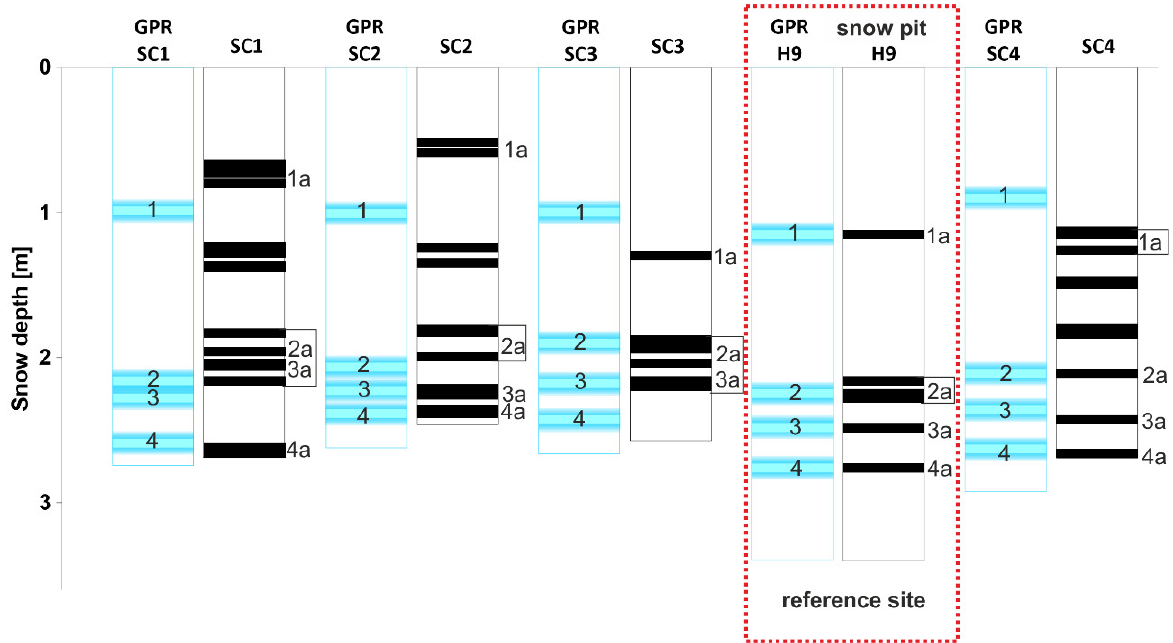
Figure 11. HLs recognized in snow cores, snow pit H9, and the nearest sections of GPR profile. A total of 1–4—HLs identified in the GPR profile; 1a–4a—HLs identified in snow cores corresponding to layers 1–4. Reference site H9 (HLs in the snow pit and corresponding GPR section is marked with a red dotted rectangle). Location of the GPR profile and snow cores (SC1, SC2, SC3, SC4) is presented on Figure 1.